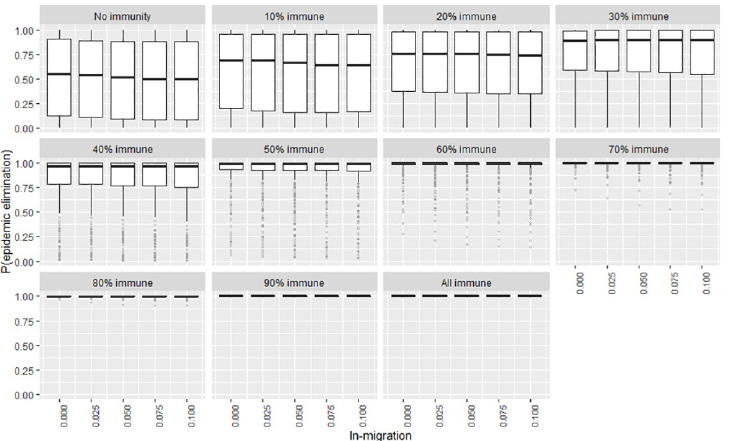
Fig 10. The certainty of the effect of in-migration rates on P(elim.) at different herd immunities. The range of possible values when other parameters not shown in this plot are varied over their ranges. The boxplot shows the median, the interquartile range, minimums and maximums (1.5 times the 1 st and 3 rd quarter values) and outliers (grey circles).